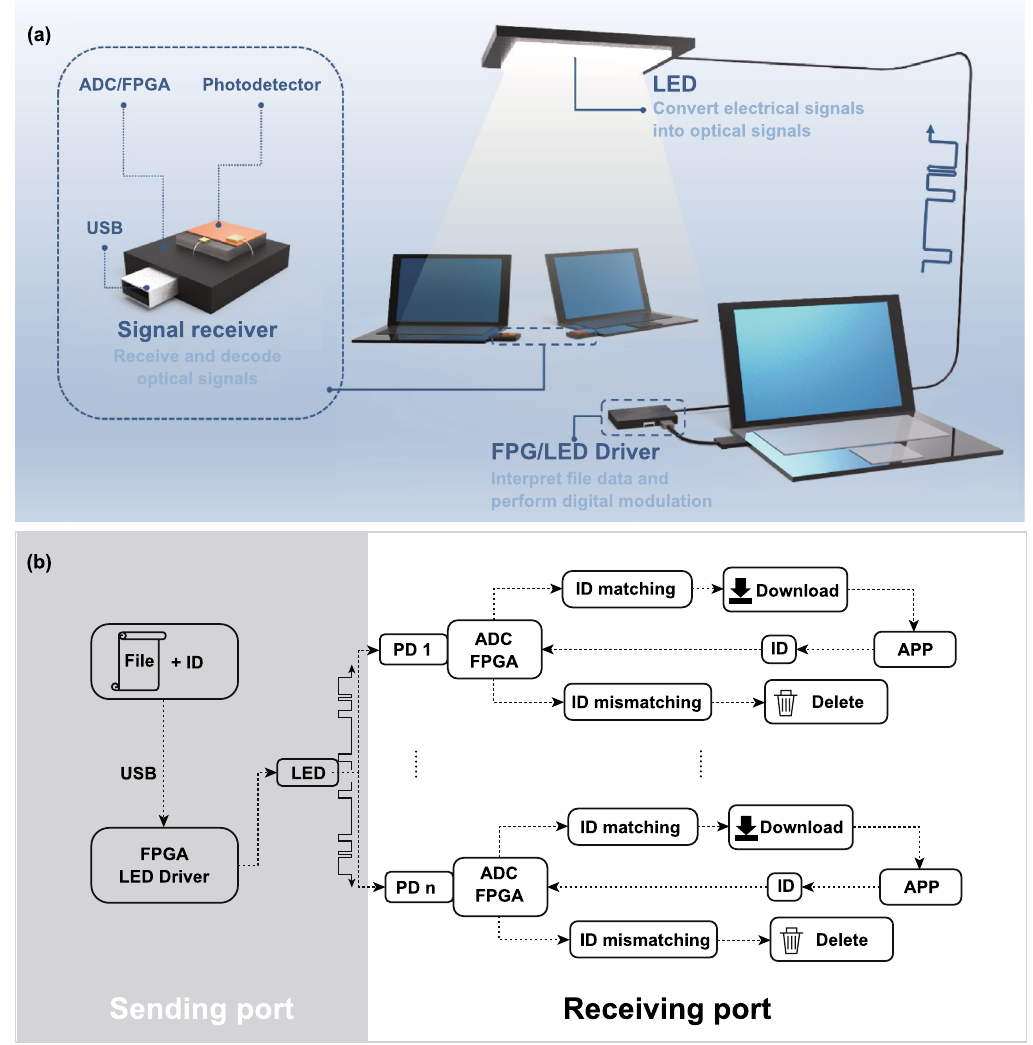
Fig. 6 a Schematic and b mechanism diagram of transmitting confidential documents by optical